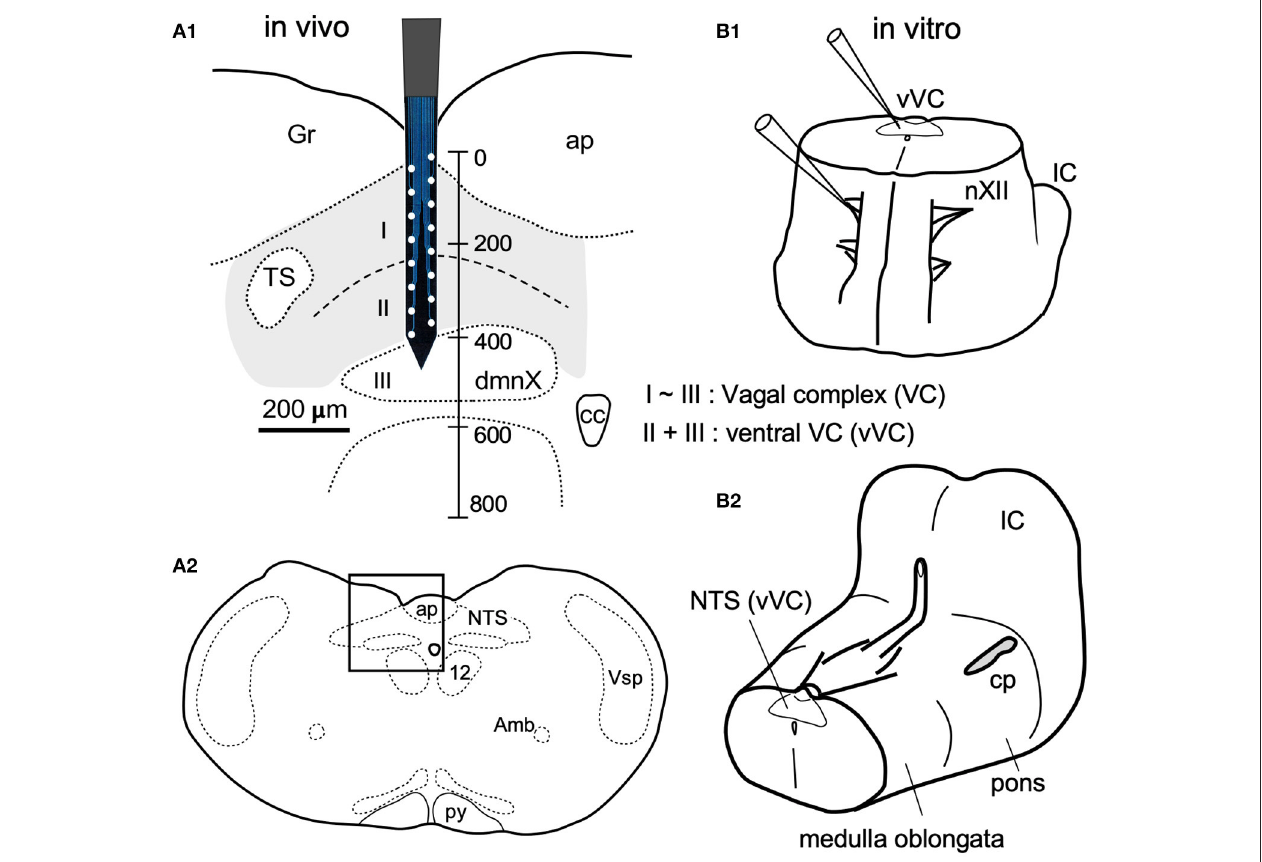
FIGURE 1 | In vivo (A) and in vitro (B) preparations for recordings of spontaneous neuronal activities from the vagal complex (VC). (A) The VC consists of the dorsal motor nucleus of the vagus (dmnX, layer III) and the nucleus of tractus solitarius (NTS, gray-shaded) that can be divided into dorsal and ventral (I and II) layers according to function and cytoarchitecture (Negishi and Kawai, 2011). A silicon electrode of 16 metal probes spanned the whole depth of the VC (a vertical scale in µ m). (A1) is magnified from a frame in (A2) . (B1) An upright ponto-medulla block preparation of newborn rats. (B2) Cerebellum was detached from this preparation. Amb, ambiguus nucleus; ap, area postrema; cc, central canal; cp, cerebellar peduncle (cut); Gr, gracilis nucleus; IC, inferior colliculus; nXII (12), hypoglossal nucleus; py, pyramidal tract; Vsp, spinal nucleus of the trigeminal